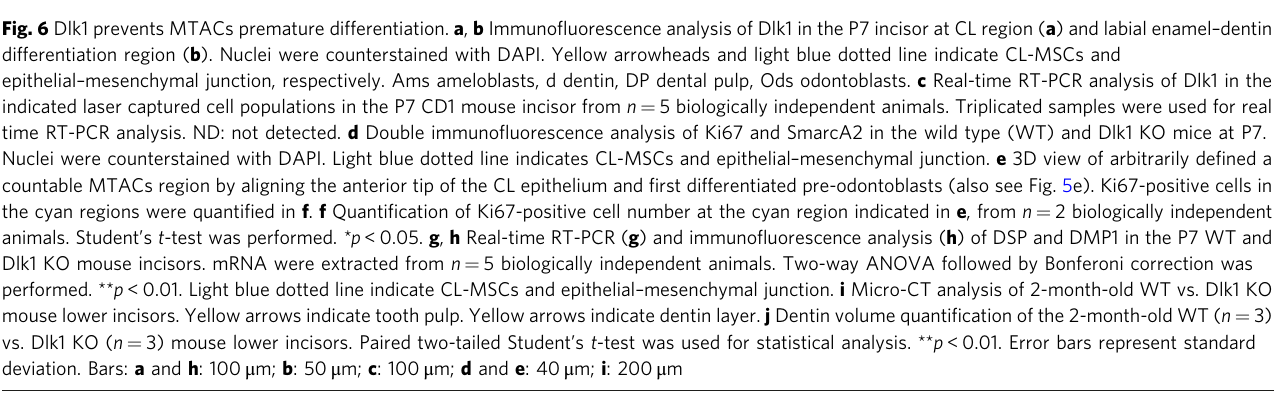
Fig. 6 Dlk1 prevents MTACs premature differentiation. a , b Immuno fl uorescence analysis of Dlk1 in the P7 incisor at CL region ( a ) and labial enamel – dentin differentiation region ( b ). Nuclei were counterstained with DAPI. Yellow arrowheads and light blue dotted line indicate CL-MSCs and epithelial – mesenchymal junction, respectively. Ams ameloblasts, d dentin, DP dental pulp, Ods odontoblasts. c Real-time RT-PCR analysis of Dlk1 in the indicated laser captured cell populations in the P7 CD1 mouse incisor from n = 5 biologically independent animals. Triplicated samples were used for real time RT-PCR analysis. ND: not detected. d Double immuno fl uorescence analysis of Ki67 and SmarcA2 in the wild type (WT) and Dlk1 KO mice at P7. Nuclei were counterstained with DAPI. Light blue dotted line indicates CL-MSCs and epithelial – mesenchymal junction. e 3D view of arbitrarily de fi ned a countable MTACs region by aligning the anterior tip of the CL epithelium and fi rst differentiated pre-odontoblasts (also see Fig. 5e). Ki67-positive cells in the cyan regions were quanti fi ed in f . f Quanti fi cation of Ki67-positive cell number at the cyan region indicated in e , from n = 2 biologically independent animals. Student ’ s t -test was performed. *p < 0.05. g , h Real-time RT-PCR ( g ) and immuno fl uorescence analysis ( h ) of DSP and DMP1 in the P7 WT and Dlk1 KO mouse incisors. mRNA were extracted from n = 5 biologically independent animals. Two-way ANOVA followed by Bonferoni correction was performed. ** p < 0.01. Light blue dotted line indicate CL-MSCs and epithelial – mesenchymal junction. i Micro-CT analysis of 2-month-old WT vs. Dlk1 KO mouse lower incisors. Yellow arrows indicate tooth pulp. Yellow arrows indicate dentin layer. j Dentin volume quanti fi cation of the 2-month-old WT ( n = 3) vs. Dlk1 KO ( n = 3) mouse lower incisors. Paired two-tailed Student ’ s t -test was used for statistical analysis. ** p < 0.01. Error bars represent standard deviation. Bars: a and h : 100 μ m; b : 50 μ m; c : 100 μ m; d and e : 40 μ m; i : 200 μ